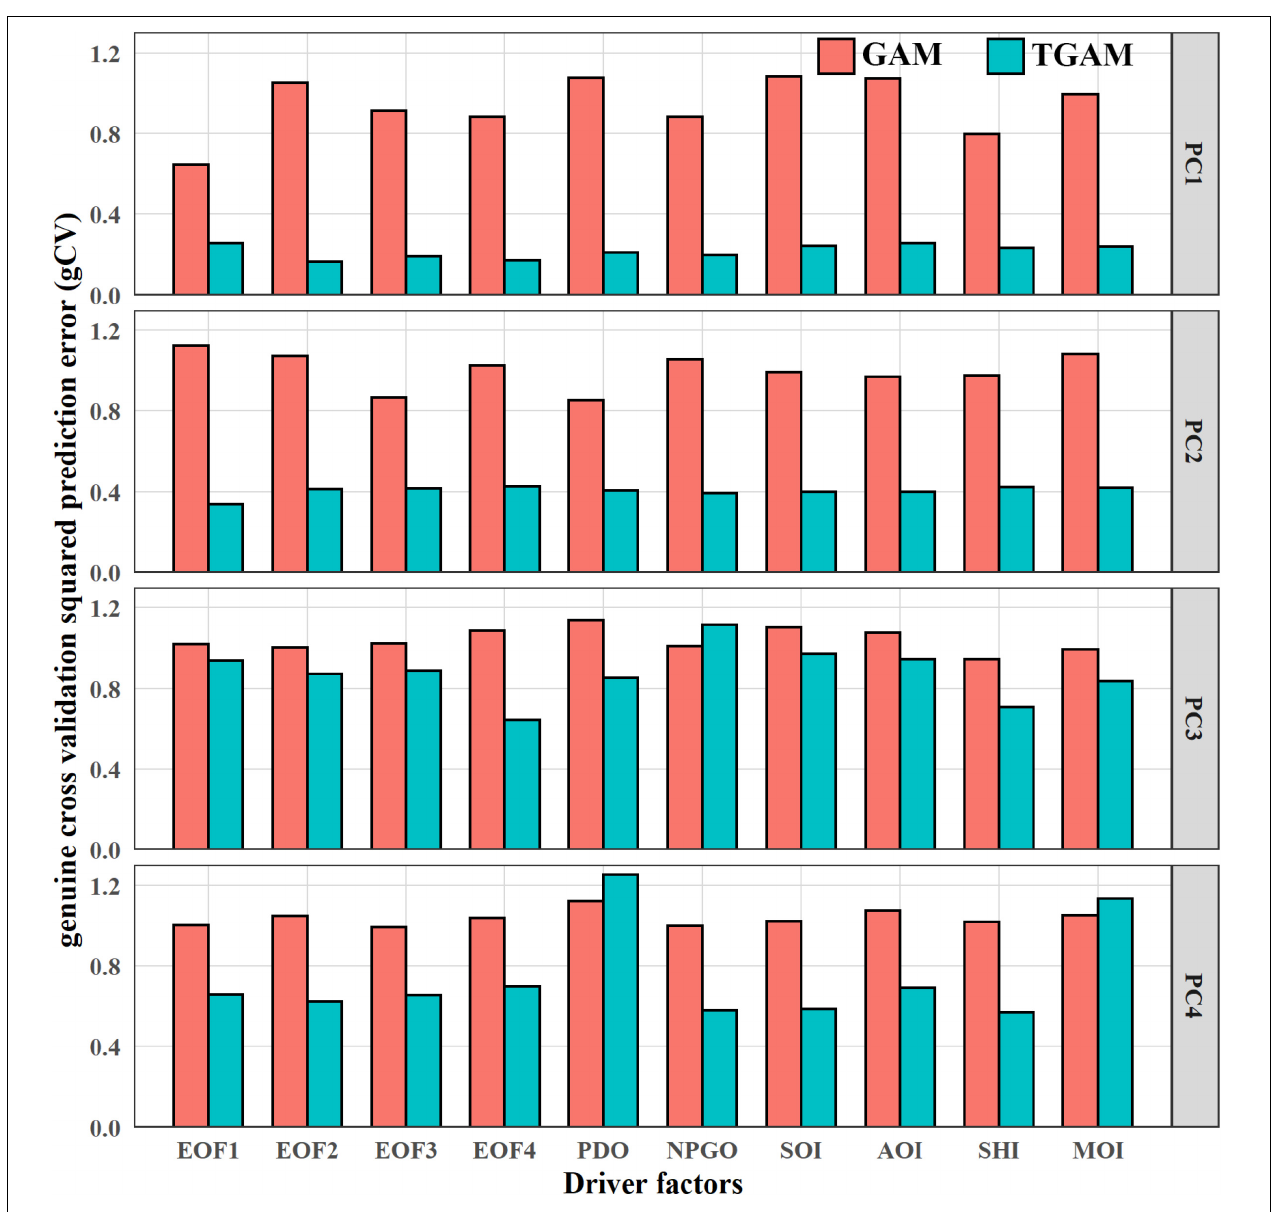
FIGURE 8 | Model comparisons between stationary and non-stationary models. Red bars show the “genuine” cross validation squared prediction error (gCV) of stationary models (GAMs), and blue bars show gCV of non-stationary models